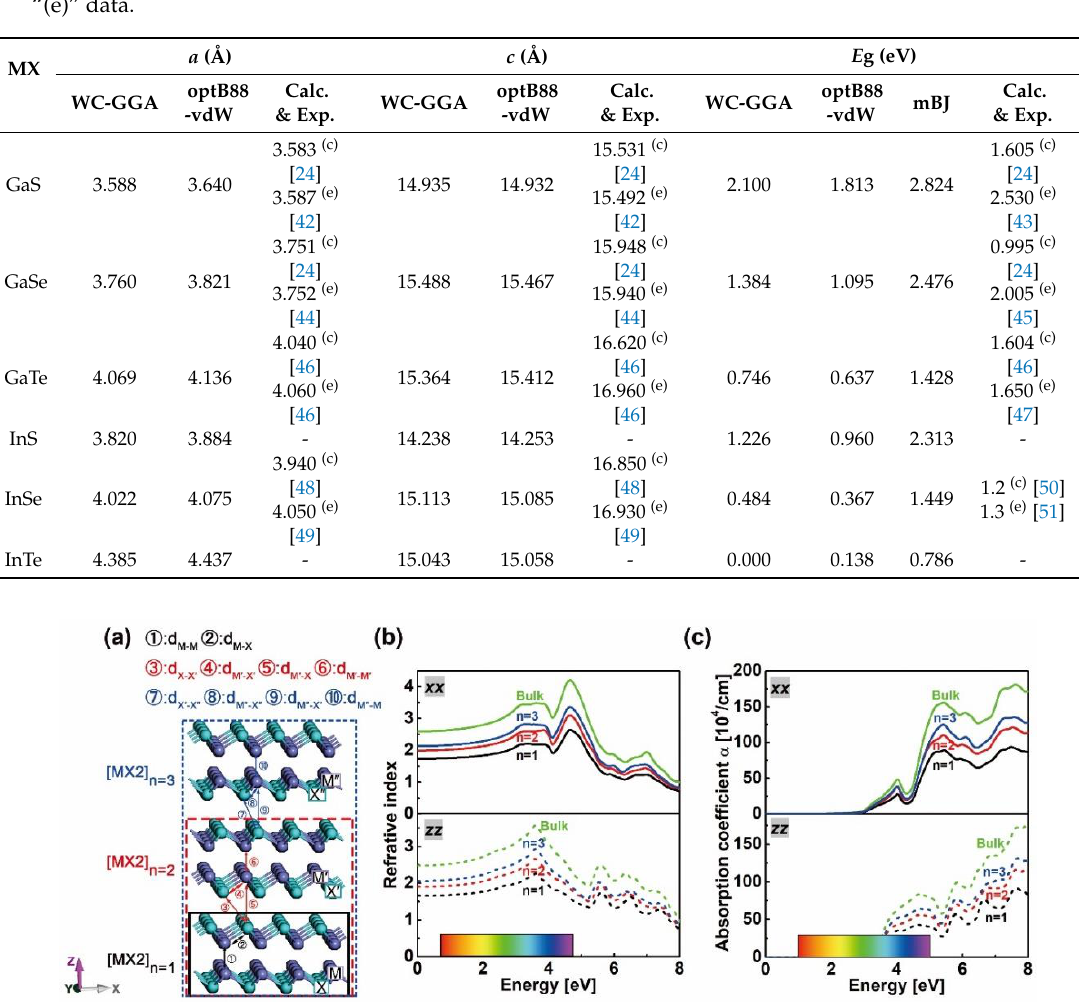
Figure 1. Schemes of [MX] n supercells with M = Ga, In and X = S, Se, Te slabs for n equals to 1, 2 and 3 respectively ( a ). Atoms from the first, second and third X–M–M–X unit in the relevant slabs are marked as [M,X], [M’,X’] and [M’’,X’’], respectively. Refractive index ( b ) and absorption coefficient ( c ) of bulk and layered [GaS] n . Table 1. Calculated lattice constants a and c and bandgaps of bulk MX (M = Ga, In; X = S, Se, Te) by using WC-GGA, optB88-vdW and mBJ functionals, as well as other theoretical “(c)” and experimental “(e)” data.